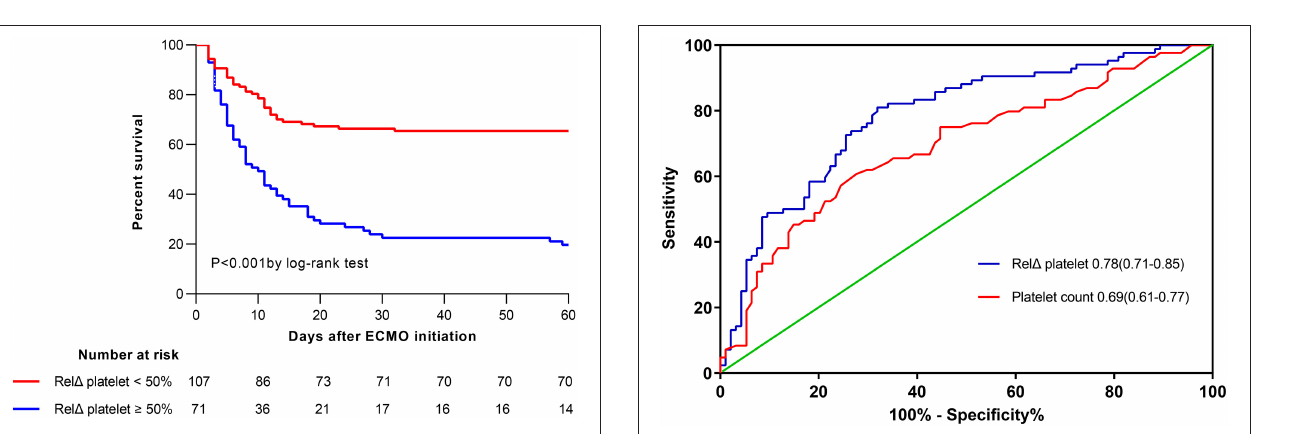
FIGURE 3 | Kaplan-Meier estimates of cumulative probabilities of 60-day survival for patients according to Rel 1 platelet ≥ 50 or < 50%. ECMO, extracorporeal membrane oxygenation; Rel 1 platelet, relative decrease in platelet count.